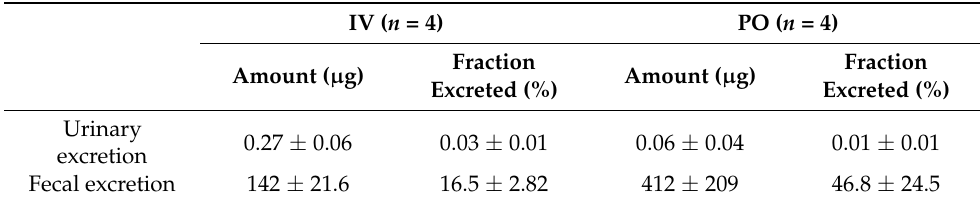
Table 3. Amount of drug excreted and unchanged fraction of excreted dose after intravenous or oral administration in rats (5